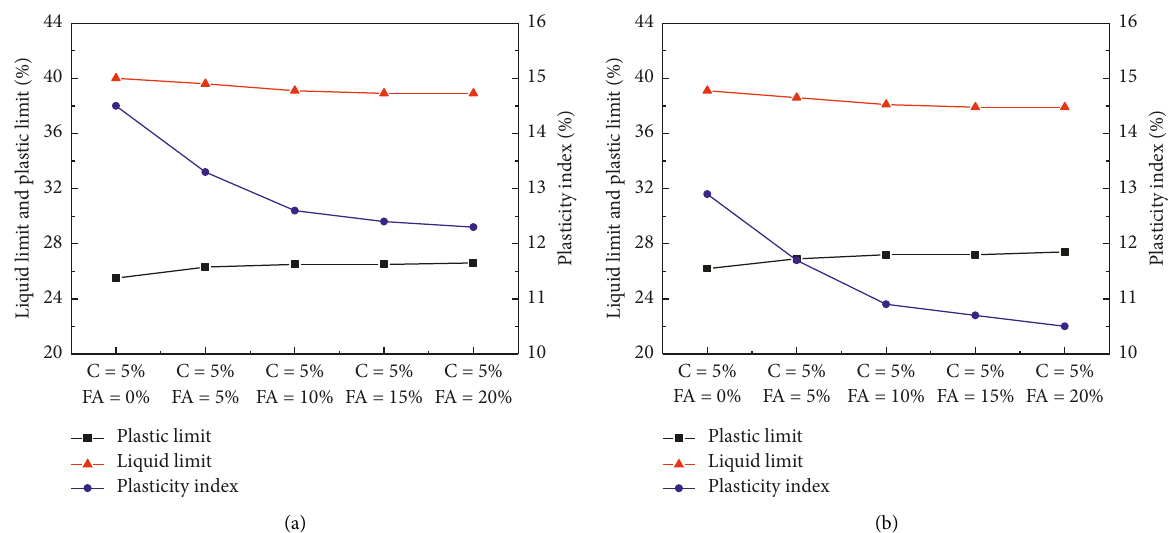
Figure 8: The Atterberg limits of cement-fly ash-stabilized soil under different curing periods. (a) 7 days. (b) 28 days.